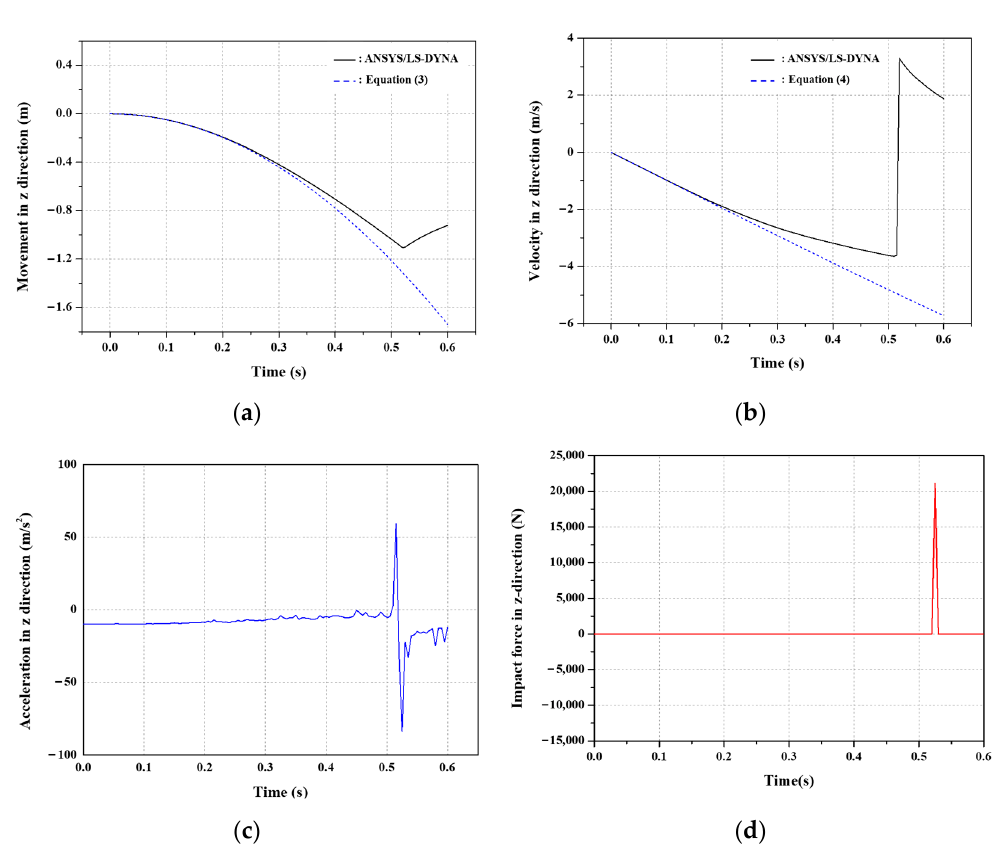
Figure 14. The results of B-2 scenario: ( a ) Movement; ( b ) velocity; ( c ) acceleration; ( d ); impact force. The gap is increasing around 0.3 s, which is the time that most parts of crusher were submerged underwater. It is obvious that it makes large difference because of considering constant drag coefficient, projected area and mass difference regardless of their position. It is difficult to set the drag coefficient for complex geometry model, like as the crusher. In addition, the velocity of FSI analysis at 0.52 s is − 3.65 m/s. It is less than the value of − 4.84 obtained from the equation. It is because that water resistance makes it slow.